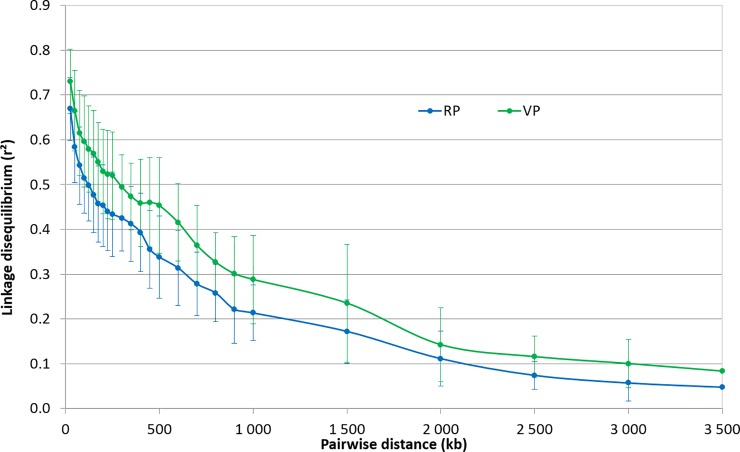
Patterns of decay in linkage disequilibrium in the reference population (RP) and in the validation population (VP).The curves represents the average r2 among the 12 chromosomes; the bars represent the associated standard deviation.